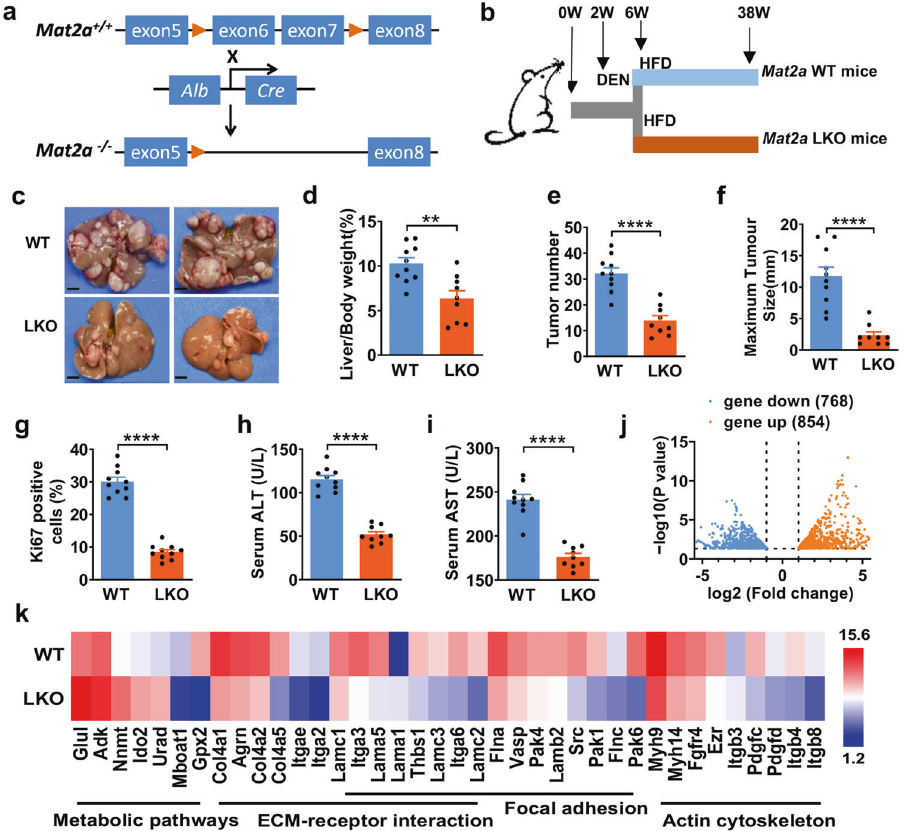
Fig. 3 MATII α is crucial for high fat-induced liver cancer progression. a Generation of liver tissue-speci fi c Mat2a -knockout mice. LoxP was indicated as arrowhead. b Schematic representation of DEN/HFD-induced HCC model. c Representative images of mouse livers from the indicated group. n = 10 (WT), n = 9 (LKO) biologically independent experiments. Scale bar, 5 mm. Quanti fi cation of the ratio of liver weight to body weight ( d ) and the number of tumors ( e ), quanti fi cation of size of the largest tumor per mouse ( f ). Mean ± s.e.m. of n = 10